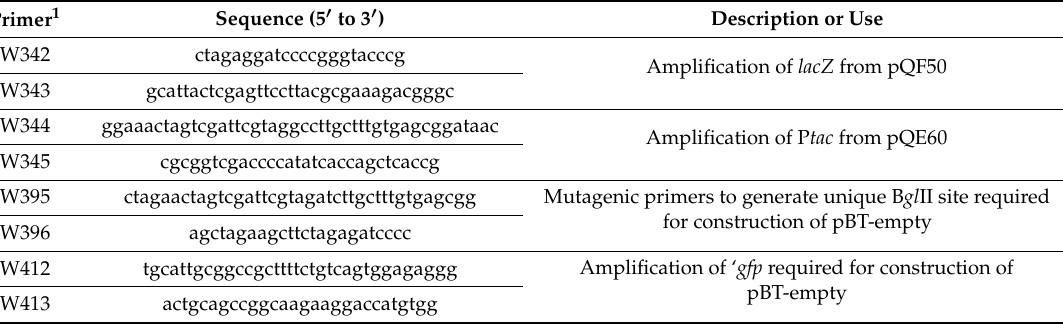
Table 2. Oligonucleotides used in this